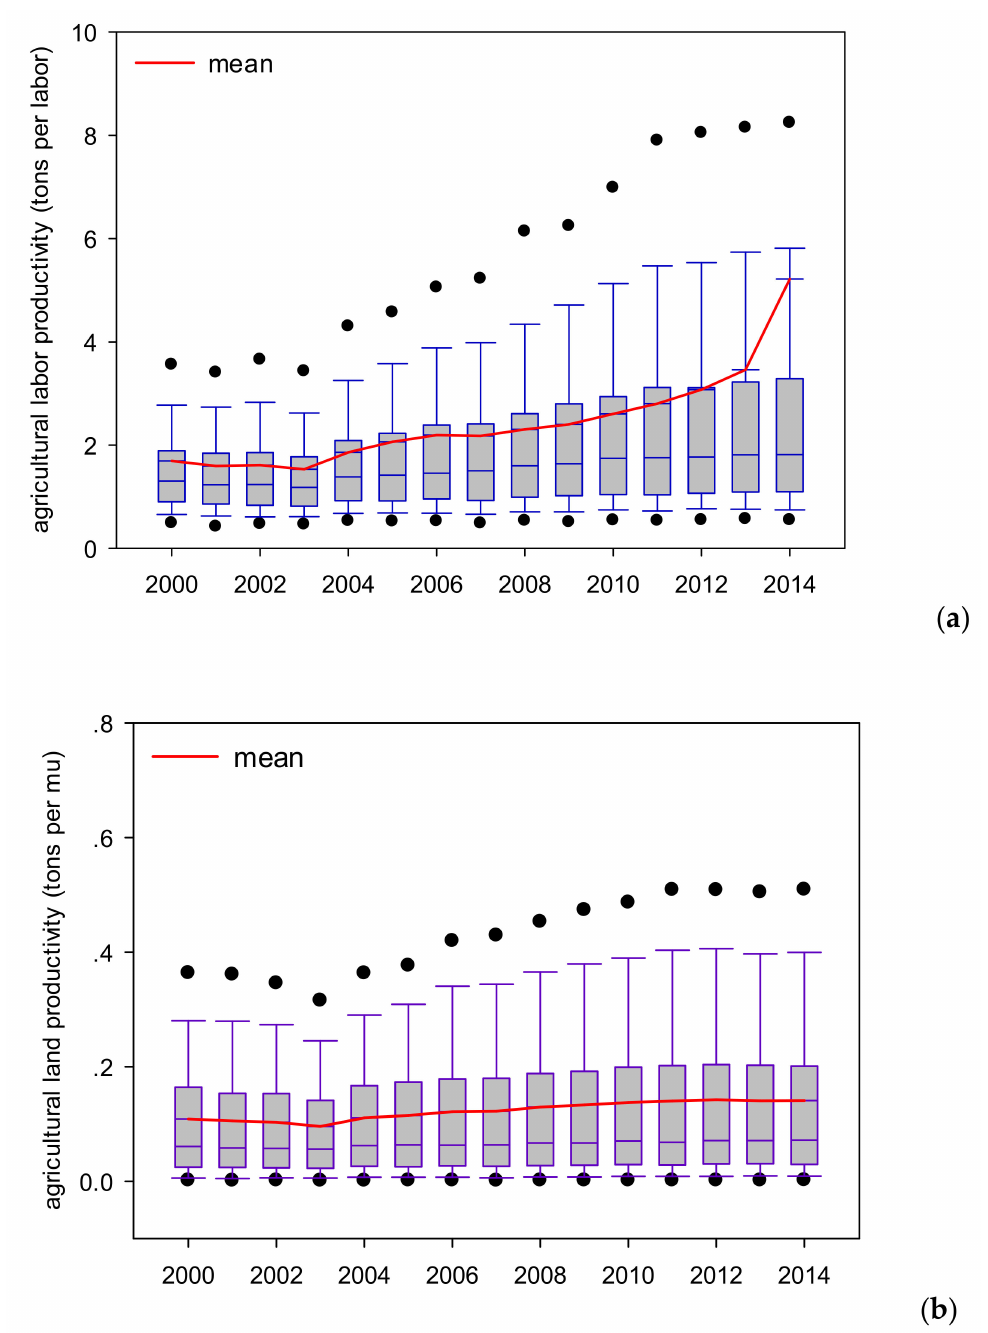
Figure 2. Agricultural labor productivity ( a ) and farmland productivity ( b ) in rural China